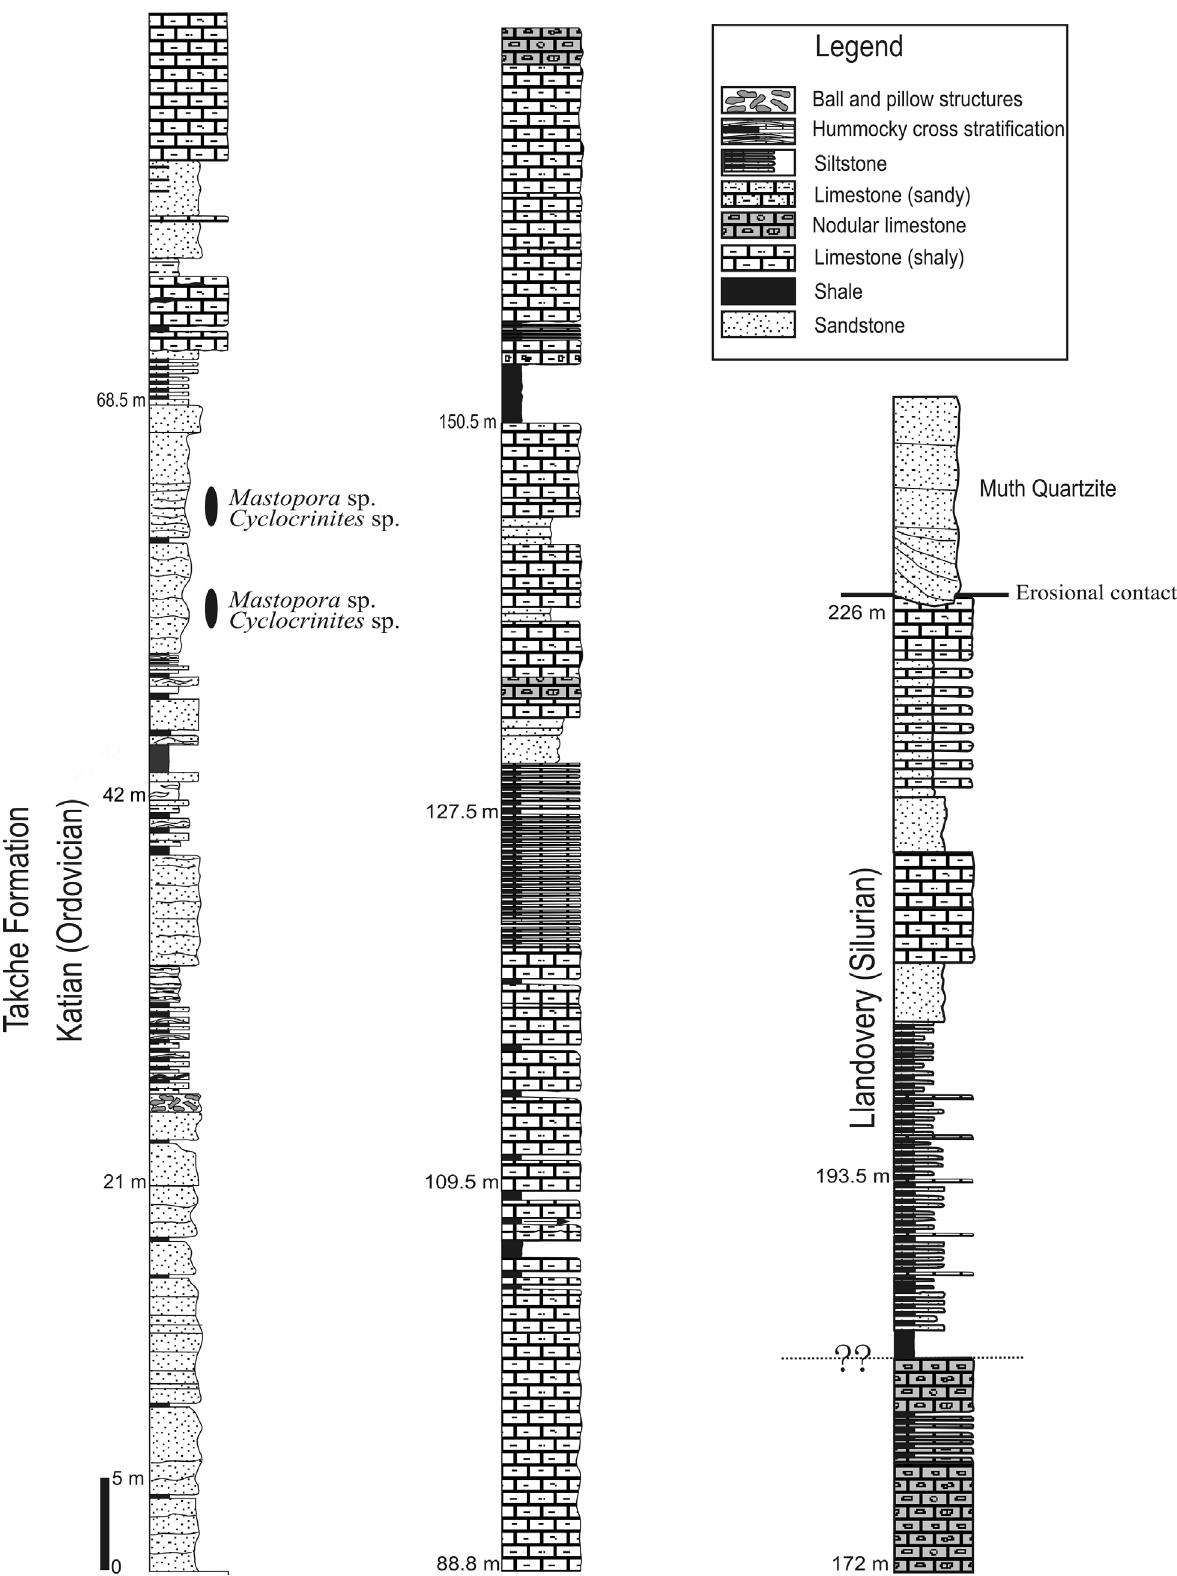
Fig. 3. Lithology of the Takche Formation measured at the Gechang locality in the Parahio Valley, Spiti,